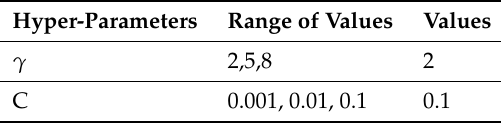
Table 6. Hyper-parameter values of